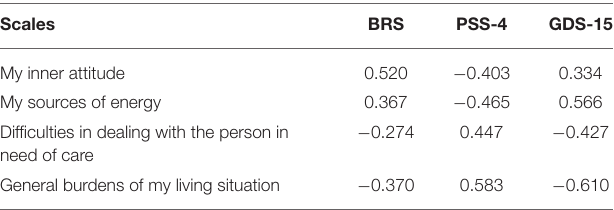
TABLE 4 | Correlations of designated ResQ-Care scales with BRS, PSS-4, GDS-15. Scales